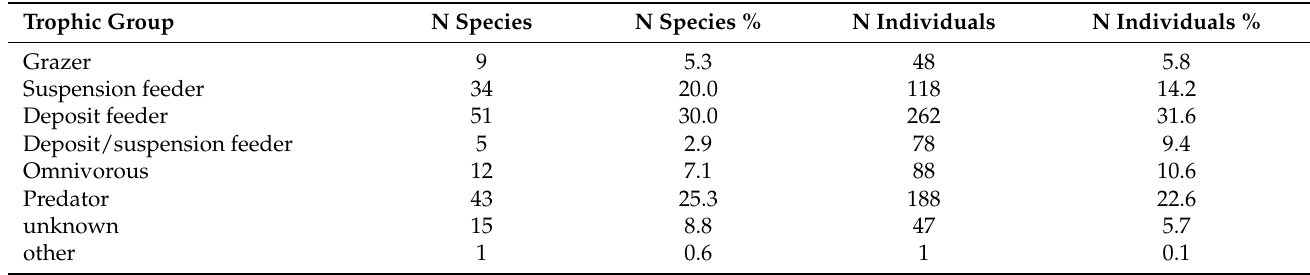
Table 2. Number of species and individuals for each trophic group.